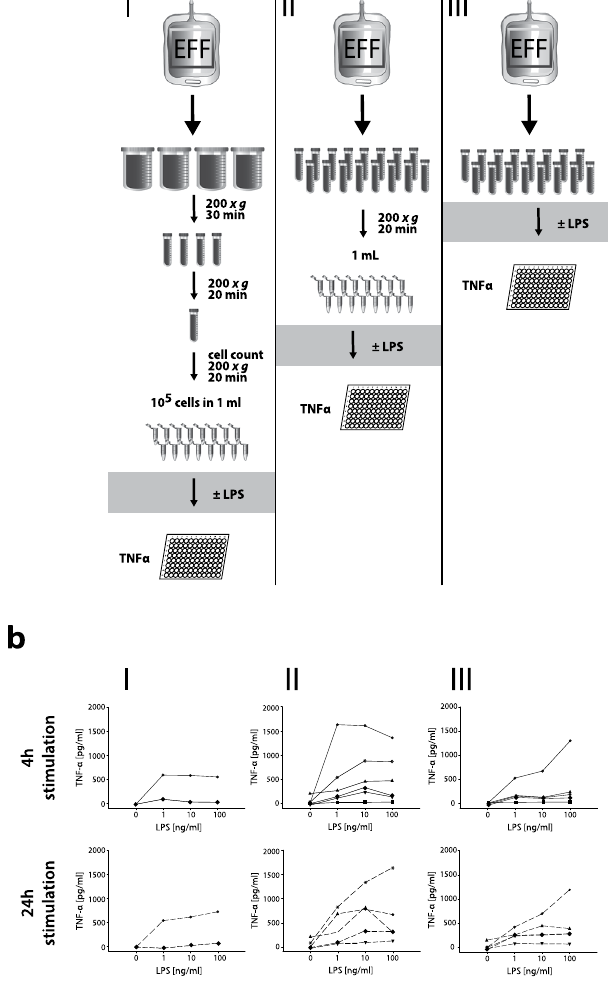
Figure 1. Bio-assay simplification. ( a ) Schematic of the simplification process for the ex-vivo stimulated cytokine release assay. Stimulations were performed as described in (I–III). ( b ) The left column (I) shows TNF- α release from a defined number of cells (10 5 cells in 1 ml). The middle and right columns show TNF- α release from an undefined number of cells concentrated from a defined volume with (II) or without (III) prior centrifugation. In 3 patients insufficient cell number prevented stimulation of a defined number of cells, and in one patient this limitation permitted completion of only the 4 h stimulation